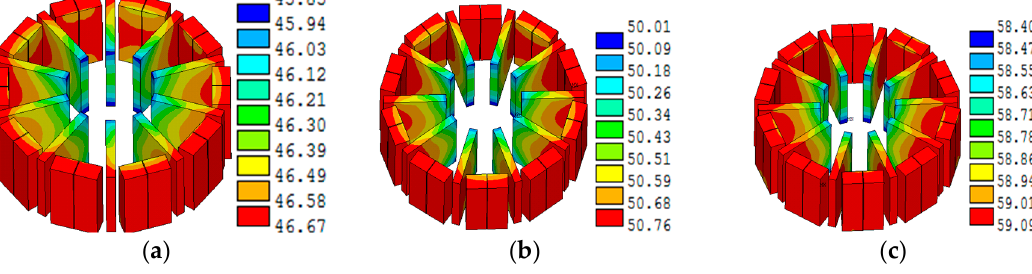
Figure 10. Temperature distributions of the permanent magnets under different AMMF (°C); ( a ) 0 At AMMF; ( b ) 600 At AMMF; ( c ) 900 At AMMF.